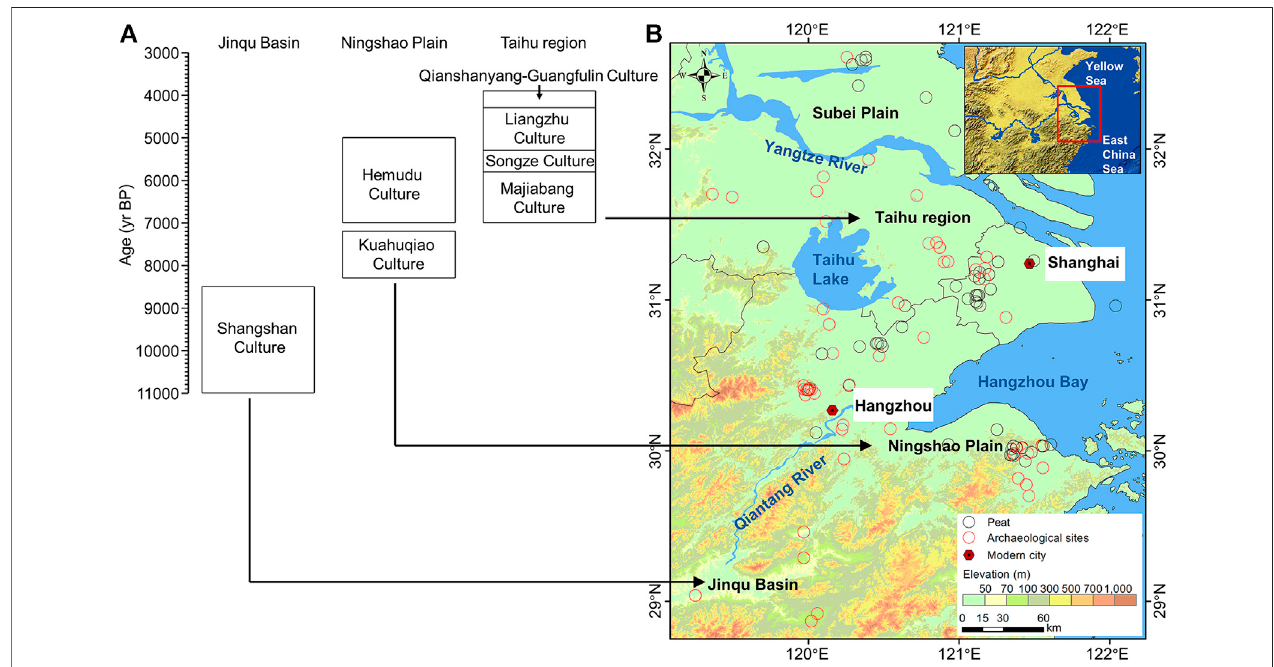
FIGURE 1 | Temporal and spatial distribution of Neolithic culture, archaeological sites, and peat in the lower Yangtze region. (A) Main cultures in the Jinqu Basin, Ningshao Plain, and Taihu region. (B) Distribution of radiocarbon dates of archaeological sites and peat. Black arrows indicate the locations of the regions on the map. Digital elevation model (DEM) data are provided by the Geospatial Data Cloud site, Computer Network Information Center, and Chinese Academy of Sciences (http:// www.gscloud.cn).